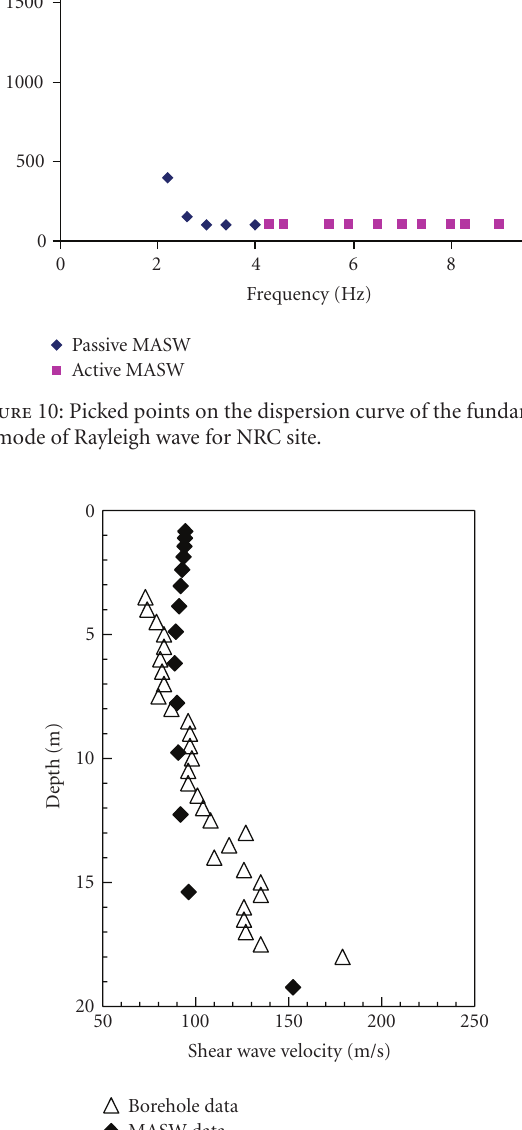
Figure 11: Comparison between shear wave velocity models based on MASW method using multilayer soil model and borehole data (downhole shear wave velocity measurement in a borehole located 30m away from MASW site) for NRCan